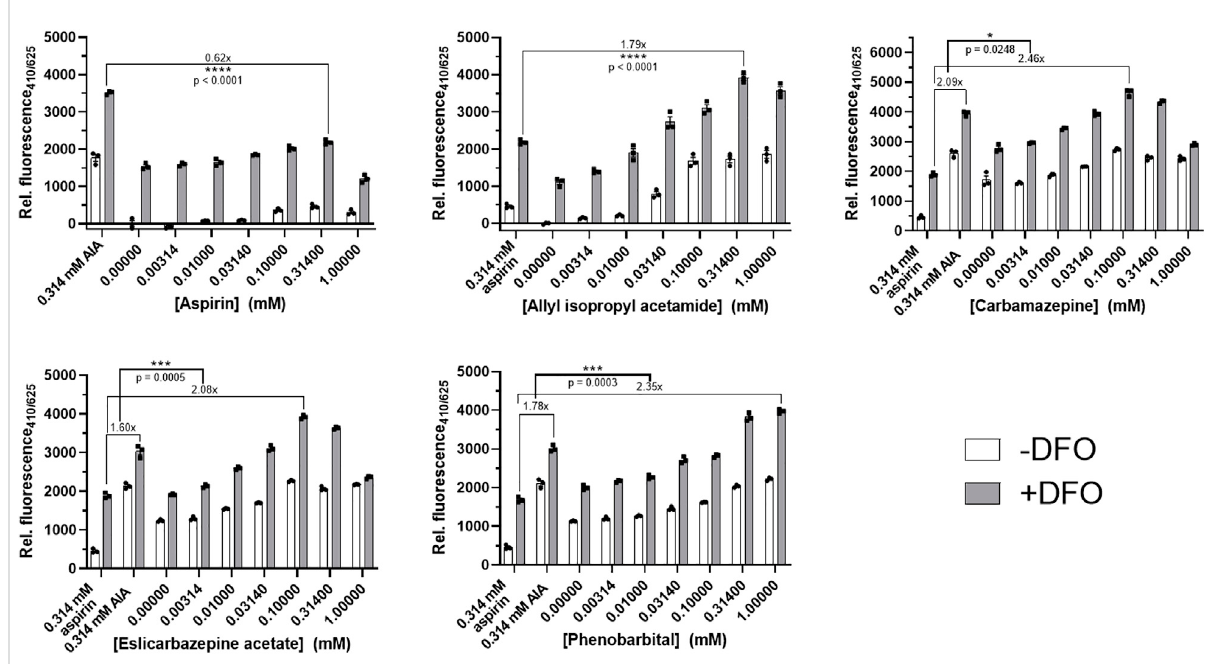
FIGURE 1 Porphyrogenicity of eslicarbazepine acetate and other compounds in LMH cells. Deferoxamine (DFO) is an iron chelator that prevents the conversion ofthe fl uorescentintermediate,protoporphyrin,intoheme.DFOisaddedinallexperimentalgroupstomimictheconditionsoftheAHPs and to increase fl uorescence measurements read by the fl uorospectrometer. 0.314 mM aspirin and allyl isopropyl acetamide were negative and positive controls, respectively, and were added in all experiments to distinguish porphyrogenicity from non-porphyrogenicity in selected compounds.Higherconcentrationsofcarbamazepine,eslicarbazepineacetate,andphenobarbitalproduced fl uorescencereadingsgreaterthanthe readings produced by 0.314 mM AIA while all concentrations of aspirin produced readings below the readings produced by AIA. All data are presented as mean values ±SEM of three independent replicates. All results are representative of three independent experiments. A two-sided Student ’ s t -test was used to assess statistical signi fi